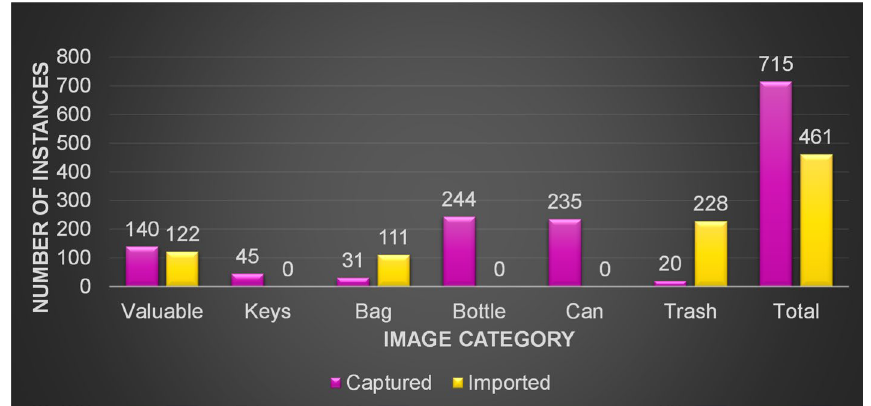
Fig. 8 Distribution of the image classes across the training dataset (quantities excluding augmentation, clean images and test